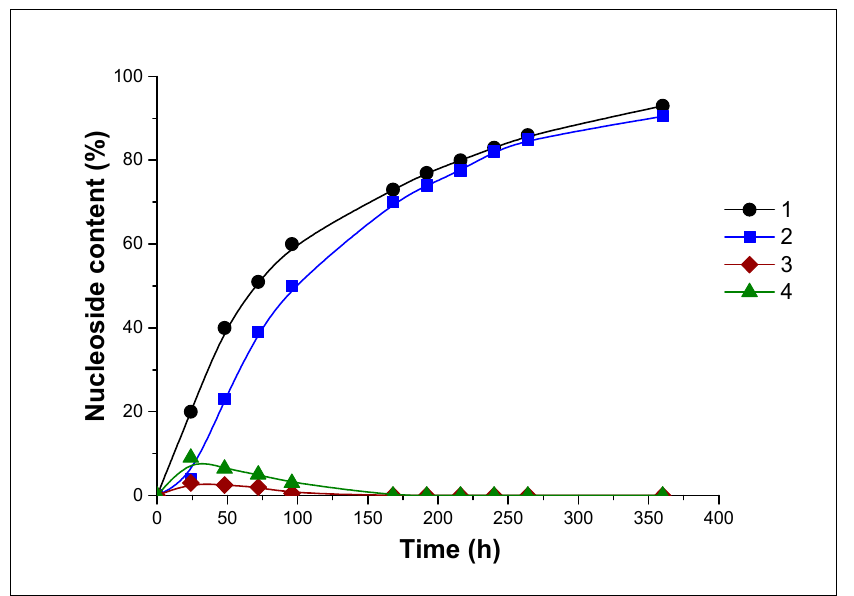
Figure 4. The percentage of nucleosides 10 and 12 in the reaction mixtures during hydrolysis of 11 (pH 7.0) in H 2 O (curves 1 and 3) and in D 2 O (curves 2 and 4). 1, 2—nucleoside 10 , 3, 4—nucleoside 12 .